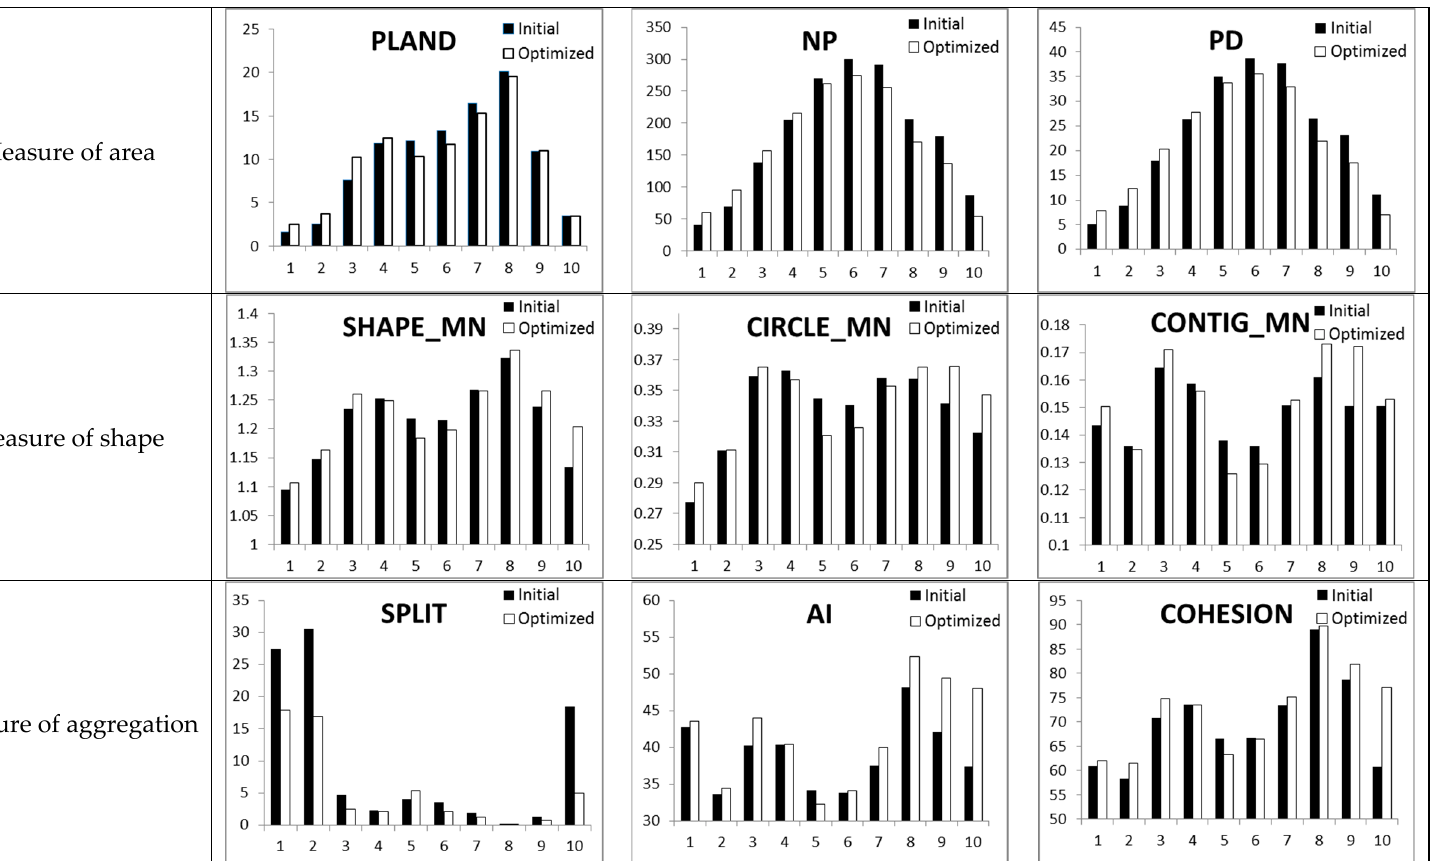
Figure 12. Landscape pattern index statistics under patch class scale: the percent of landscape (PLAND), number of patches (NP), patch density (PD), mean shape index (SHAPE_MN), mean related circumscribing circle (CIRCLE_MN), mean contiguity index (CONTIG_MN), aggregation index (AI), splitting index (SPLIT), and patch cohesion index (COHESION).